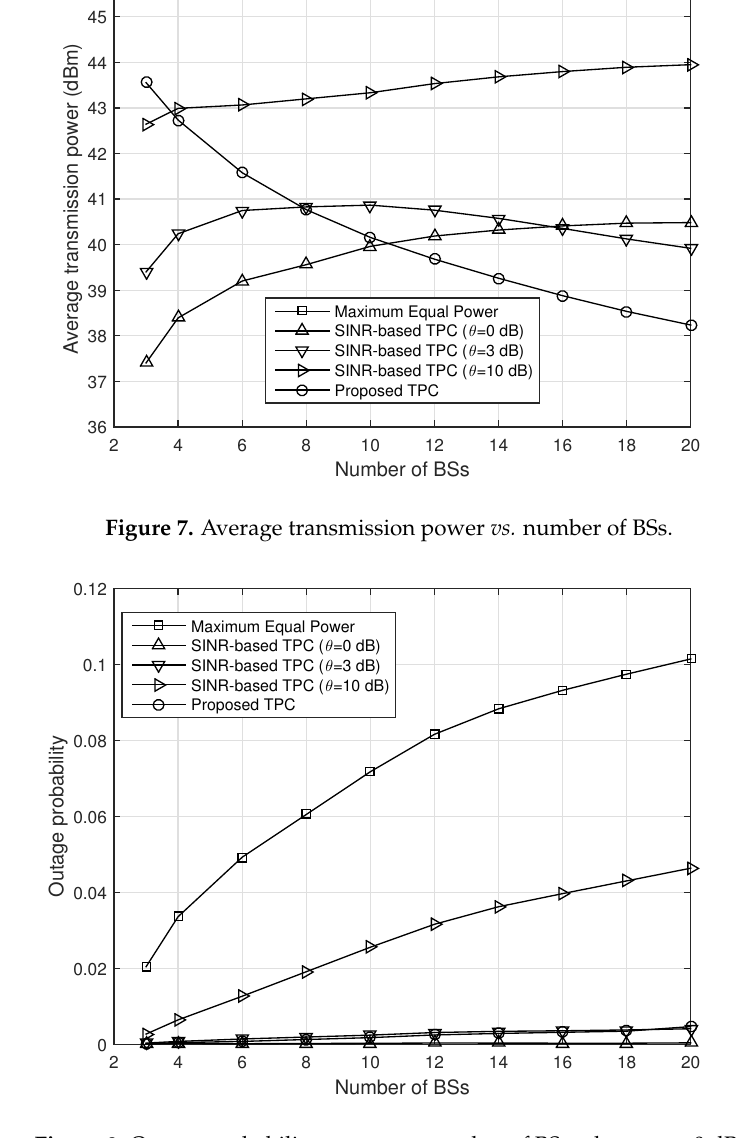
Figure 8. Outage probability power vs . number of BSs when γ req = 0